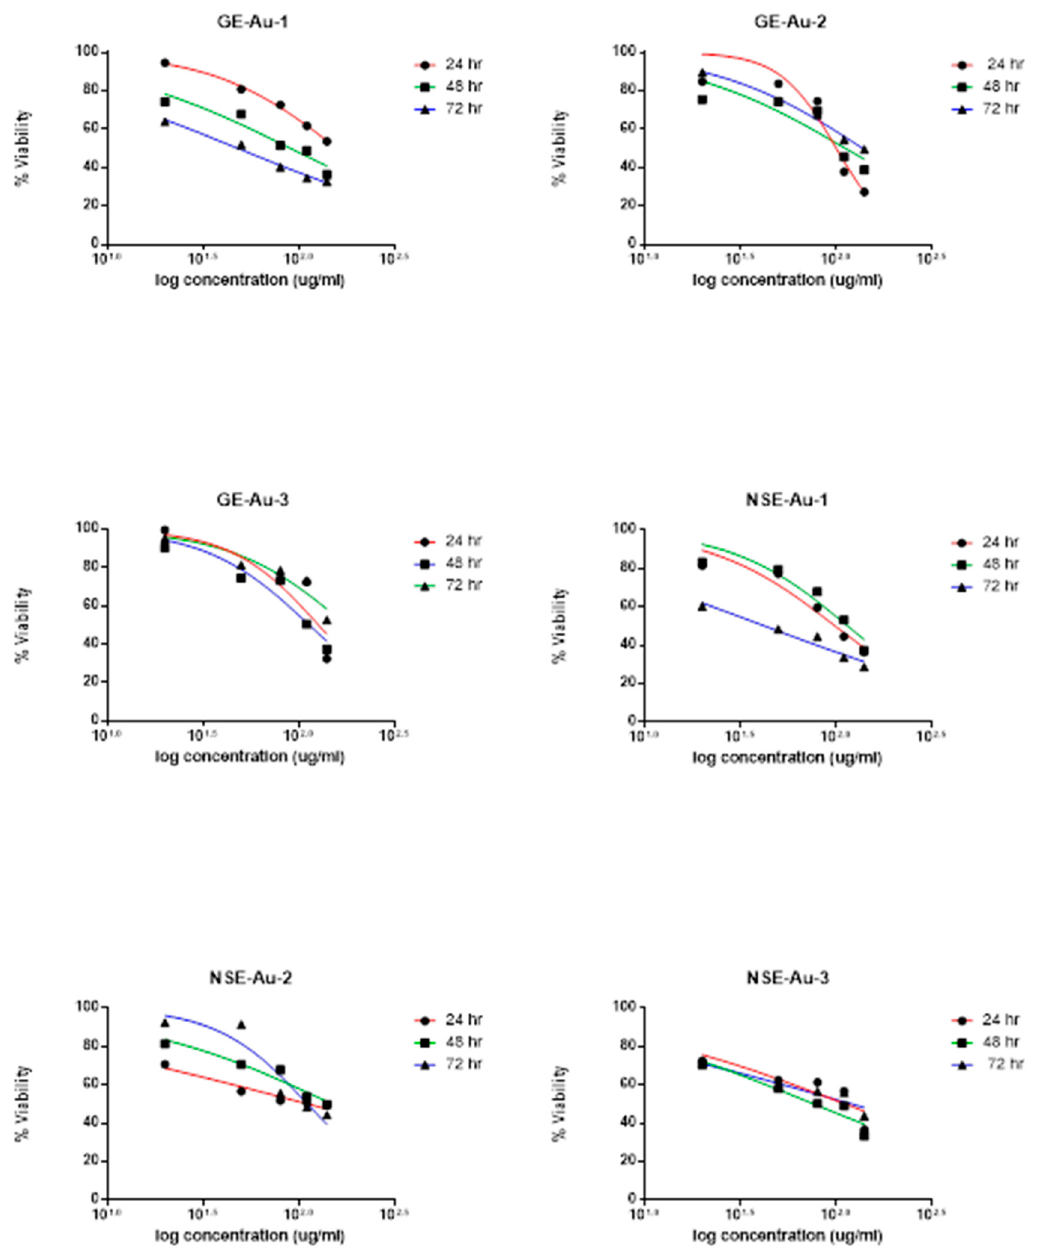
Figure 8. Cytotoxicity of various concentrations of GE- and NSE-conjugated Au-NPs against the HCT 116 cancer cell lines at different time points. Results are shown as mean ± SD (n = 3).